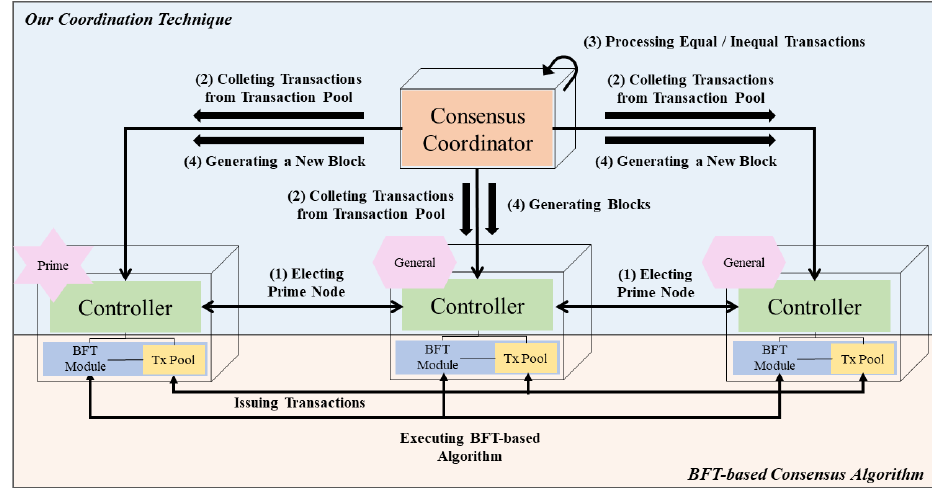
Figure 2. Overview of the coordination technique for scalable BFT-based